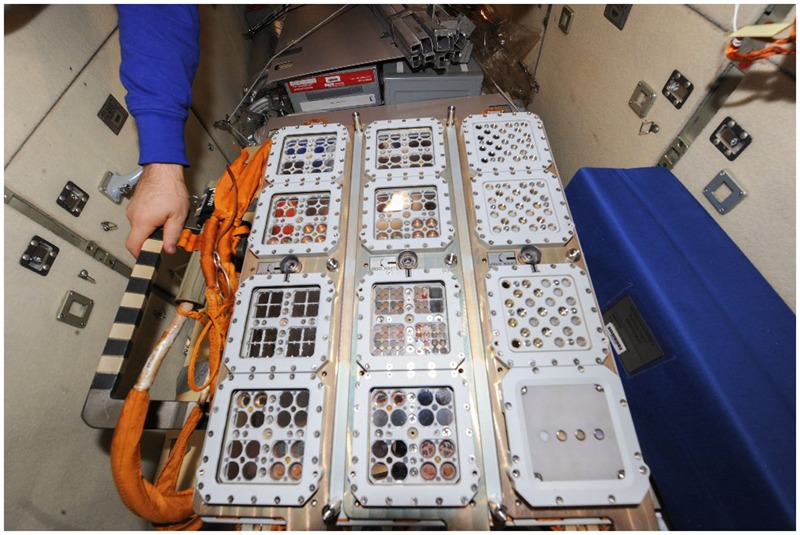
The EXPOSE-R2 trays integrated into the EXPOSE-R monoblock inside the ISS. Credit ESA, ROSCOSMOS.